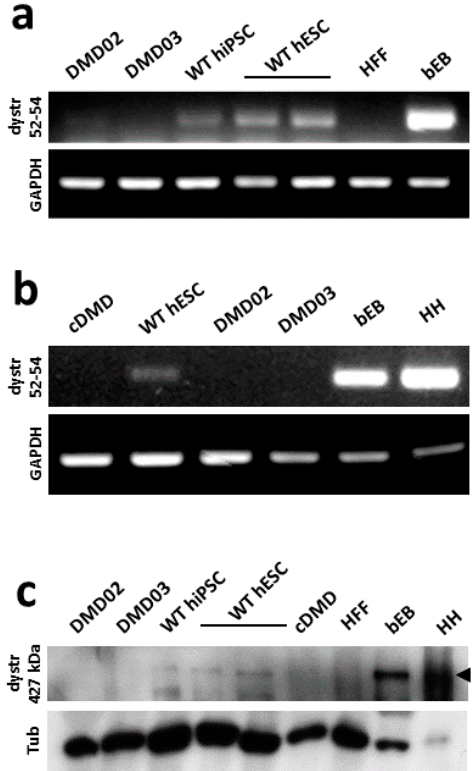
Figure 2. WT hPSC, but not DMD hPSC, express dystrophin. ( a ) Dystrophin mRNA exons 52–54 were detected by rtPCR in both WT hiPSC and hESC lines and in CM containing beating embryonic bodies (bEB). No signal was detected in DMD hiPSC lines. GAPDH was used as a loading control. Human foreskin fibroblasts (HFF) were used as negative control. ( b ) demonstrates the absence of expression of dystrophin mRNA exons 52–54 in cDMD line. For positive control, bEB and human heart (HH) sample were used. DMD02 and DMD03 hiPSC lines were used for lack of expression comparison. ( c ) High molecular weight dystrophin (dystr) protein (Dp427 isoform; antibody against N-terminal part) is expressed in pluripotent stem cells as shown by immunoblot of dystrophin expression in WT hiPSC and two WT hESC lines, while all DMD hPSC lines show complete lack 427 kDa form of dystrophin. As a positive control, human heart (HH) biopsy of non-dystrophic patient was used together with WT hESC derived bEB. HFF were used as a negative control. Tubulin (Tu) was used as a loading control. Loading of bEB and HH was adjusted not to overload dystrophin due to its high expression. DMD hPSC lines are pluripotent.